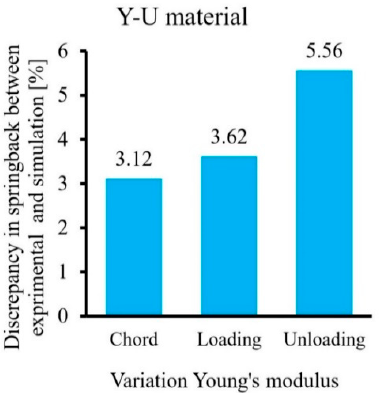
Figure 13. Discrepancy between the numerical prediction of springback (using various approaches to consider the evolution of elastic modulus) and the experimental data with Yoshida-Uemori’s model hardening for the roll forming process.